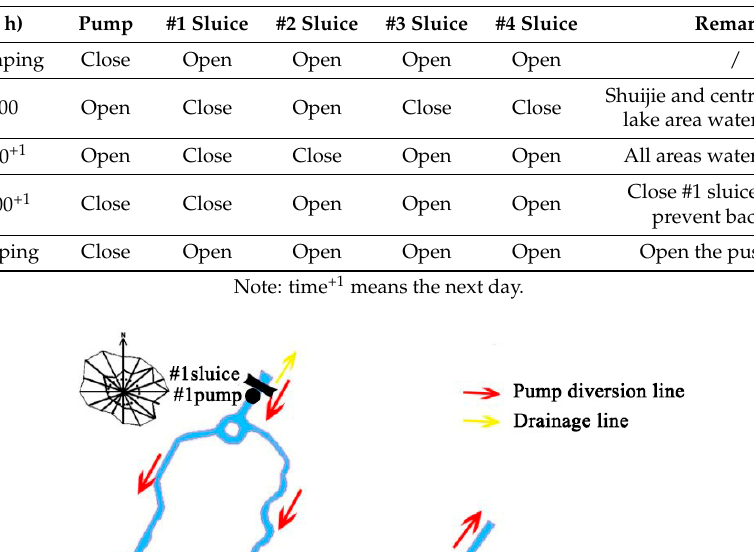
Table 4. “Three sluices and one culvert” scheduling plan during pump diversion.